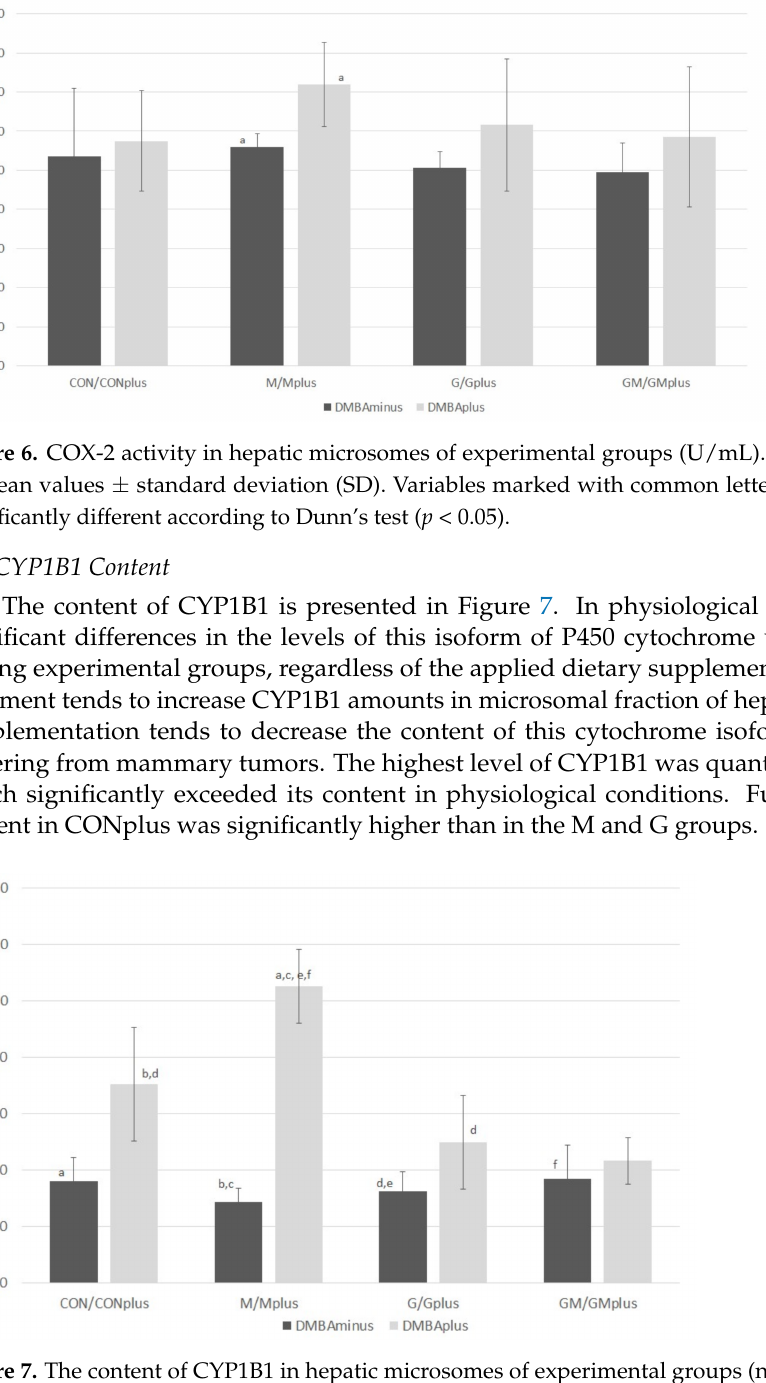
Figure 7. The content of CYP1B1 in hepatic microsomes of experimental groups (ng/mL). Data are shown as mean values ± standard deviation (SD). Variables marked with common letter indices (a–f) were significantly different according to Dunn’s test ( p <